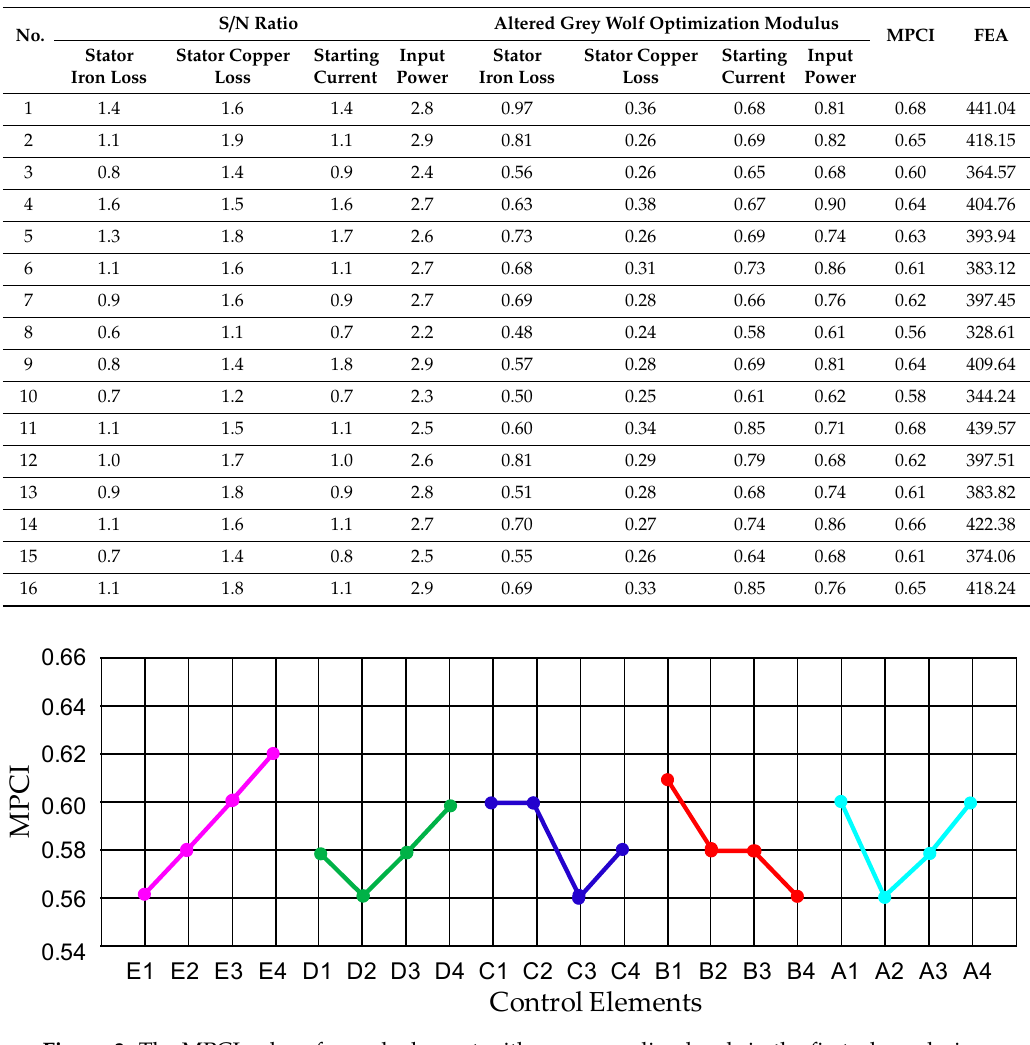
Table 3. Conversion array of signal-to-noise ( S/N) ratio, altered grey wolf optimization modulus and multiple performance characteristics index (MPCI).